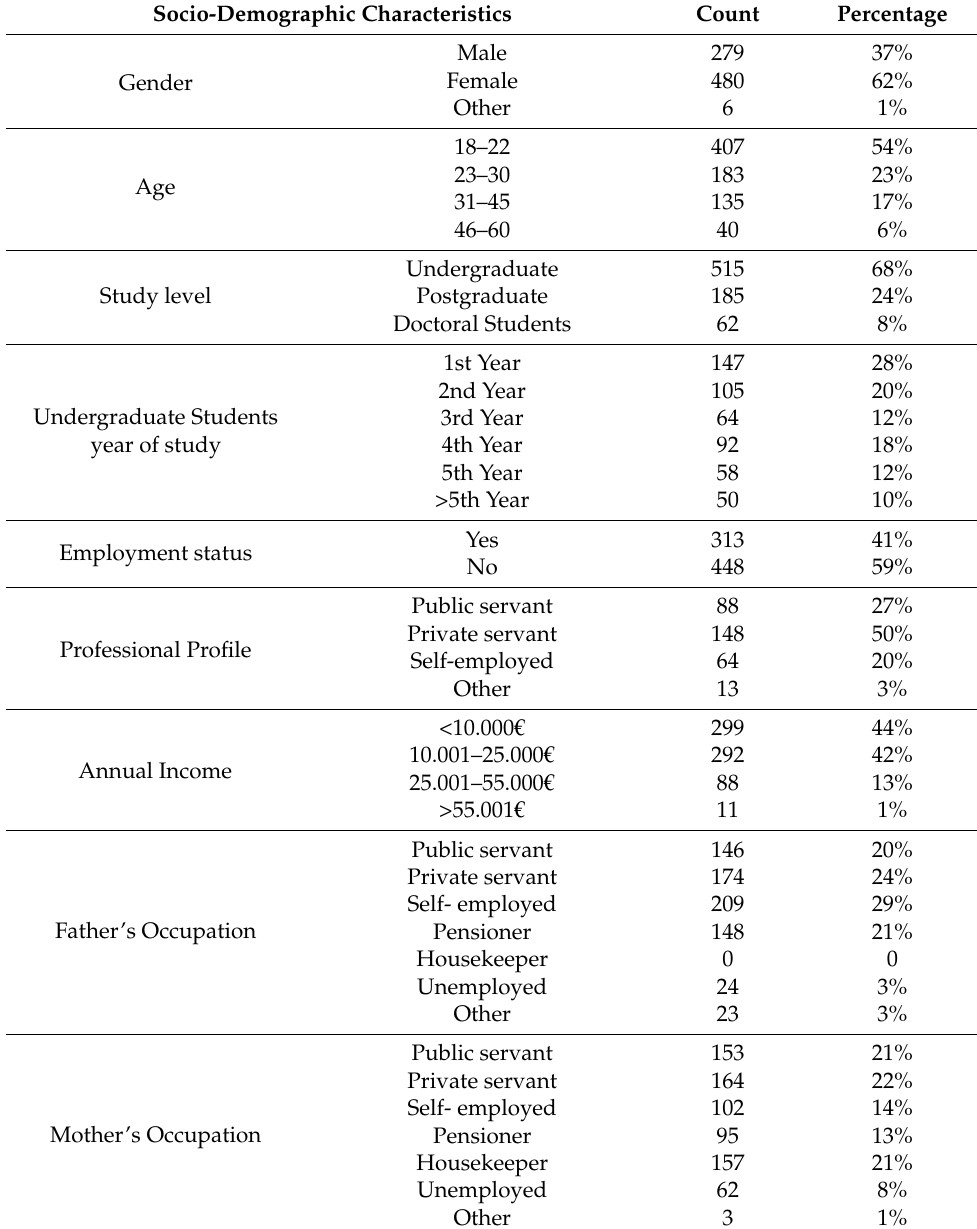
Table 1. The social and demographic attributes of the